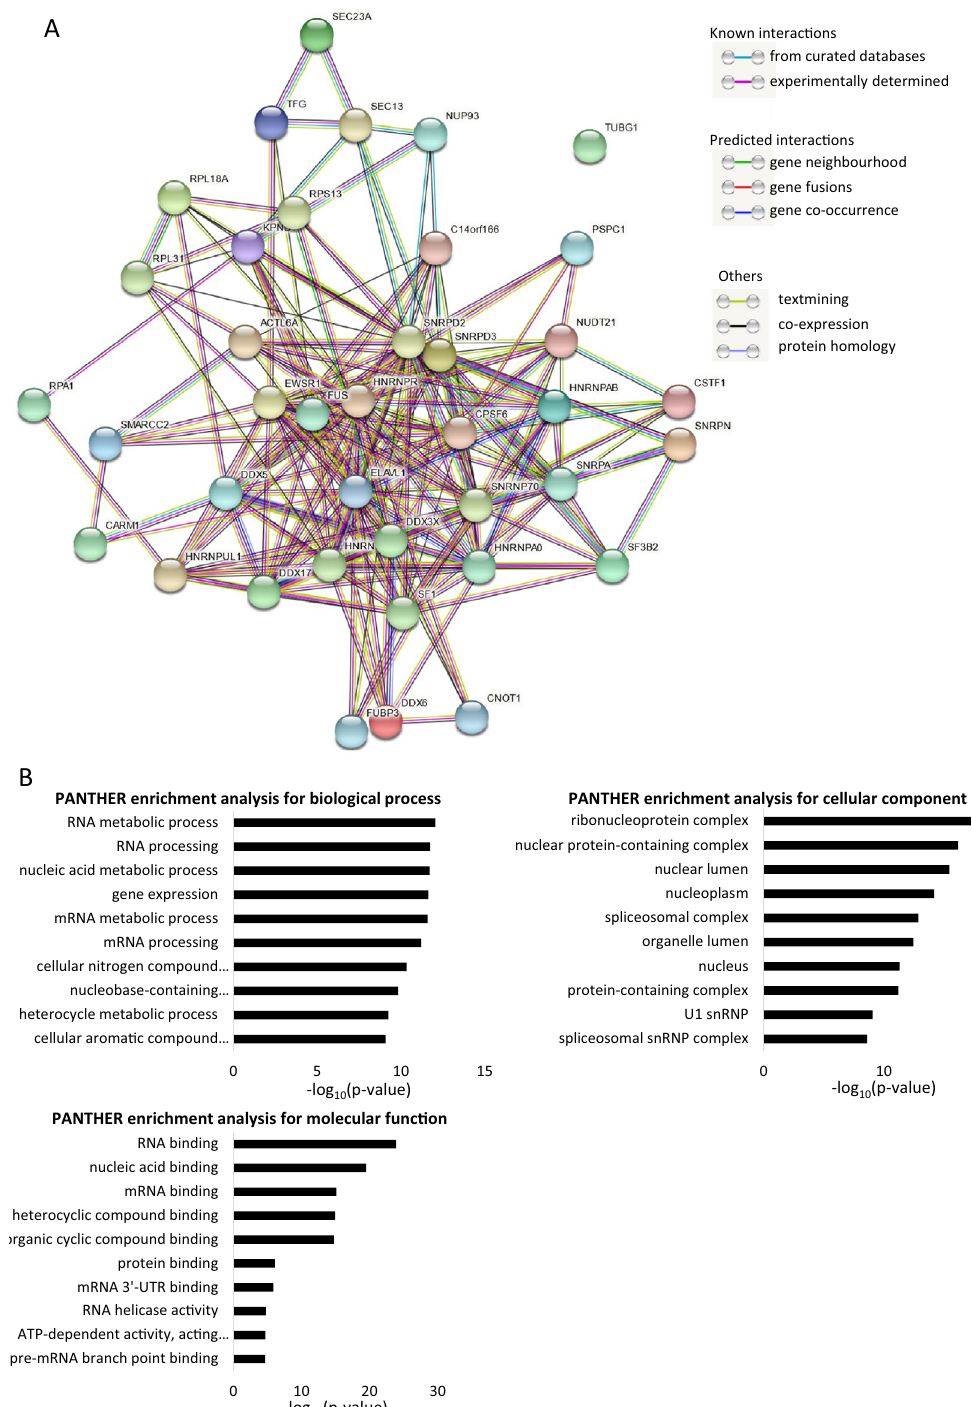
Figure 3. Protein–protein interaction network and gene ontology analyses of Kpnβ1 binding proteins common to cancer and non-cancer cells. ( A ) STRING protein–protein interaction (PPI) network analysis of 38 common Kpnβ1-interacting proteins reveals nearly all proteins are highly interconnected. A medium confidence level (0.4) was used. The circles represent proteins, while the straight lines represent the interactions between different proteins. ( B ) PANTHER gene ontology analysis of 38 Kpnβ1-interacting proteins common to cancer and non-cancer cells. The 10 most significantly enriched biological processes, cellular components and molecular functions are